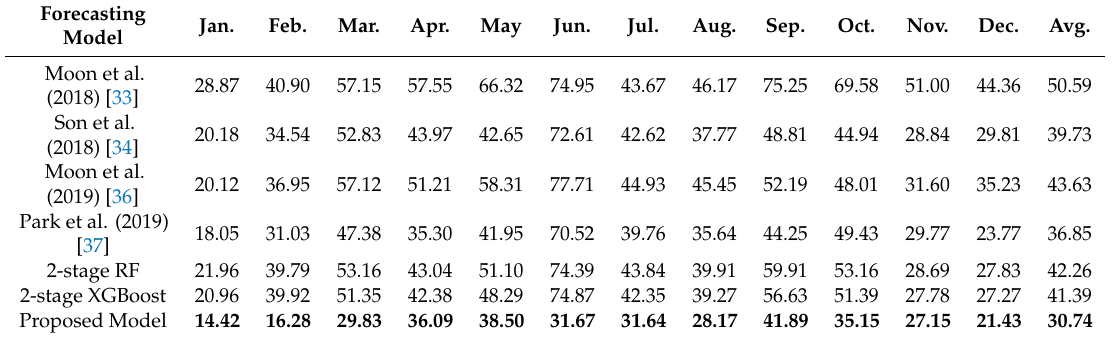
Table 10. CVRMSE comparison for each month (The best in bold).